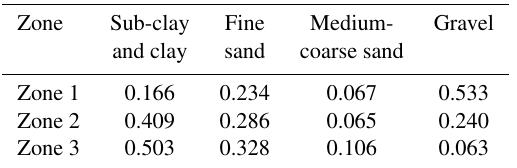
Table 1. Values of the volumetric proportion for the various facies in three zones.